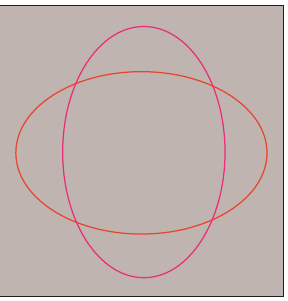
F 2: e best �t to a uniform distribution in a